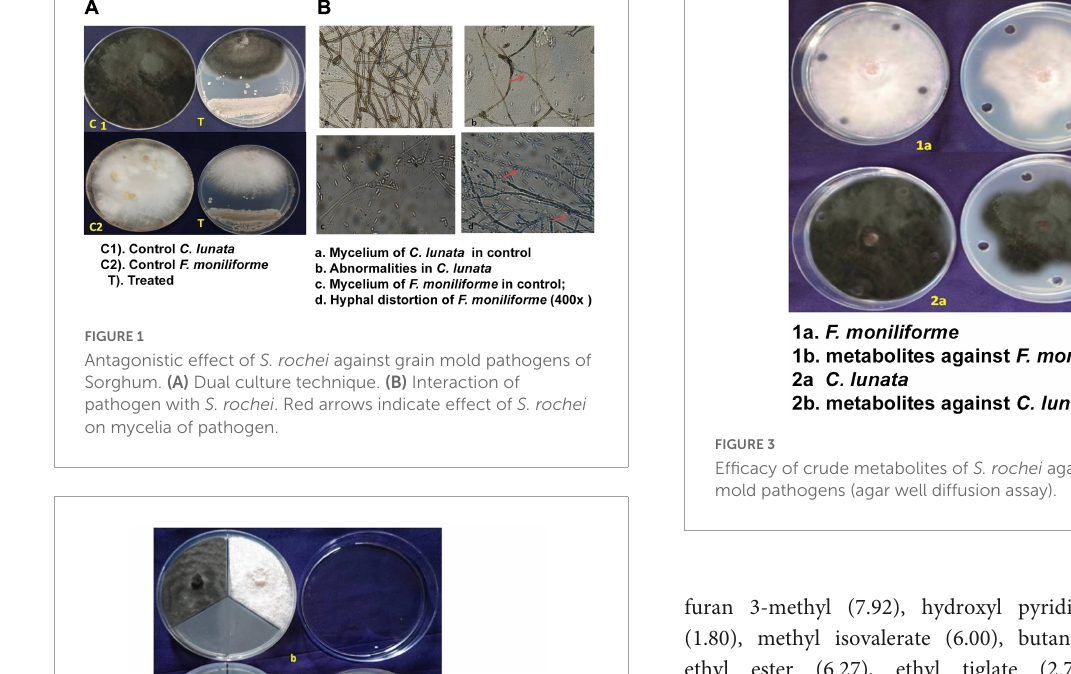
furan 3-methyl (7.92), hydroxyl pyridine (0.60),